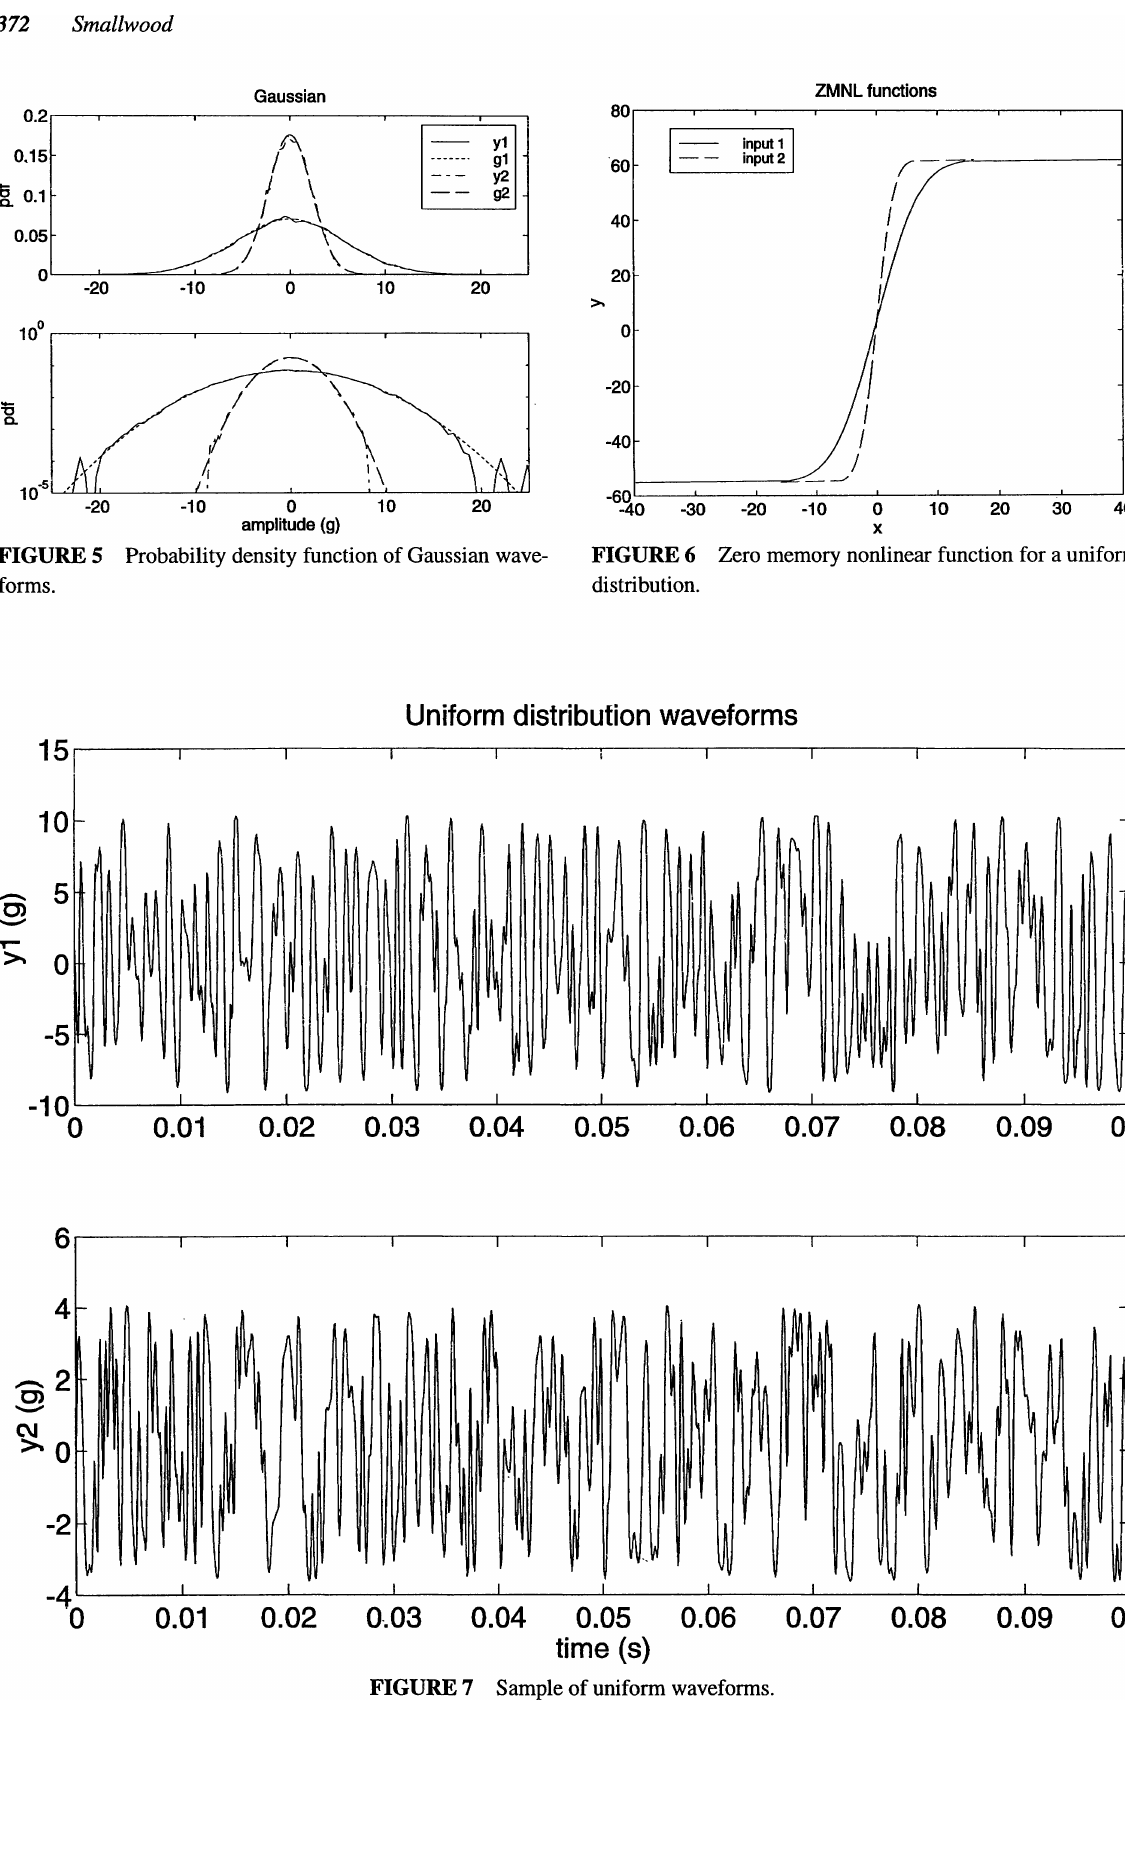
FIGURE 7 Sample of uniform